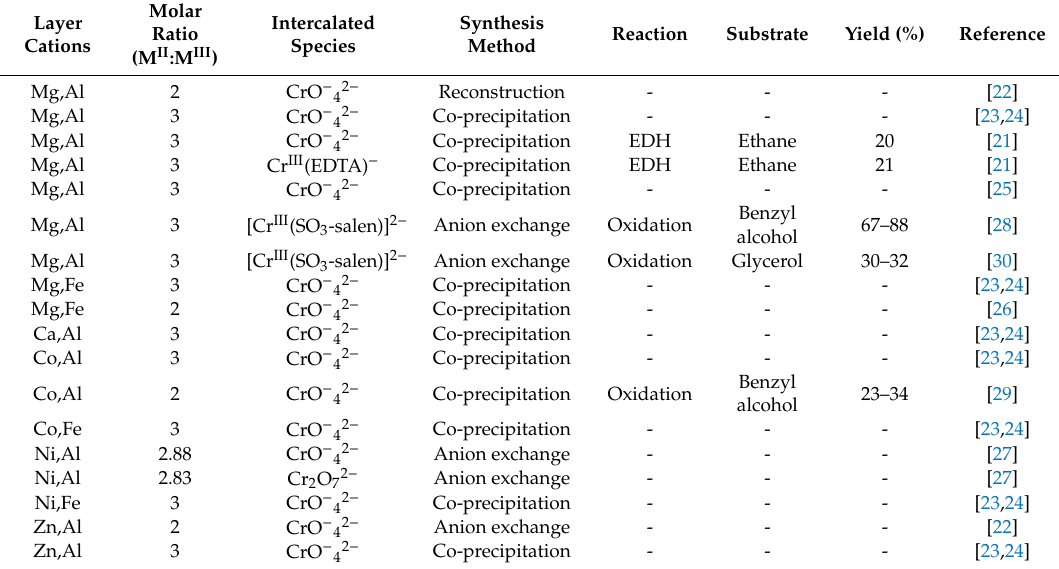
Table 1. Summary of LDH with intercalated chromium-based anions.